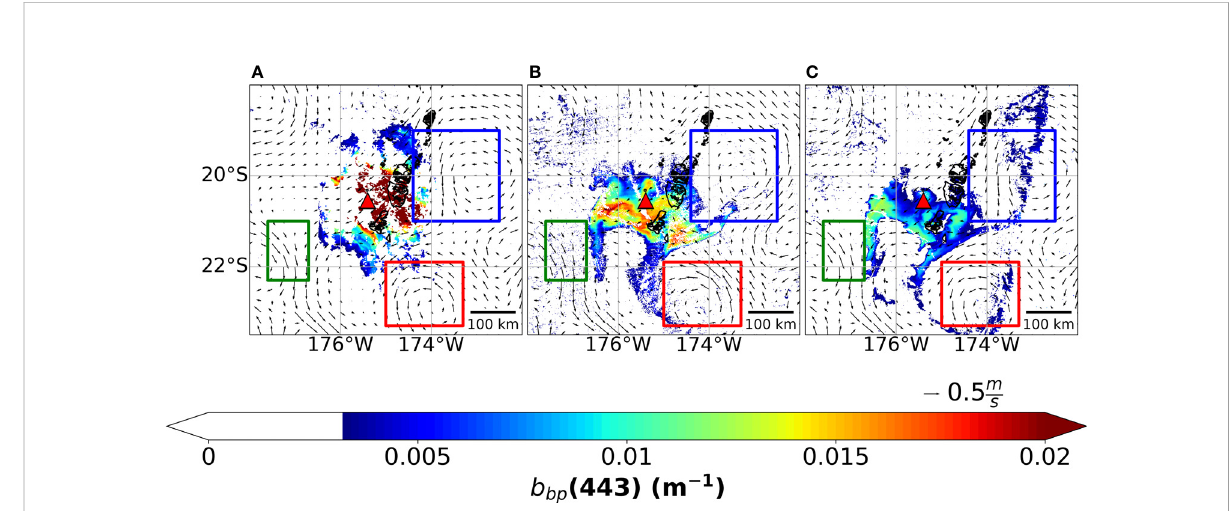
FIGURE 7 Backscattering of particles b bp (443) with superimposed CMEMS ocean surface current velocity on (A) 17 January 2022, (B) 22 January 2022, and (C) 26 January 2022. Current scale is in meters per second (the reference length of the arrow represents 0.5 m/s). The backscattering coef fi cient threshold of Whiteside et al., 2021 (>0.0032 m -1 ) was applied to delineate the patch from clouds and from oceanic water with no